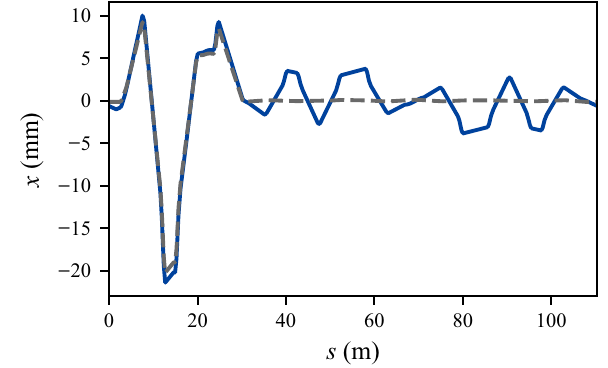
FIG. 5. Example of a nonlocalized orbit defined by the magnet strengths found by the BO algorithm (navy, solid), in comparison to the reference orbit (gray, dashed) with design values, where the injection bump orbit is fully localized. The orbit oscillation outside of the injection bump is not taken into consideration by BO, as it causes no beam